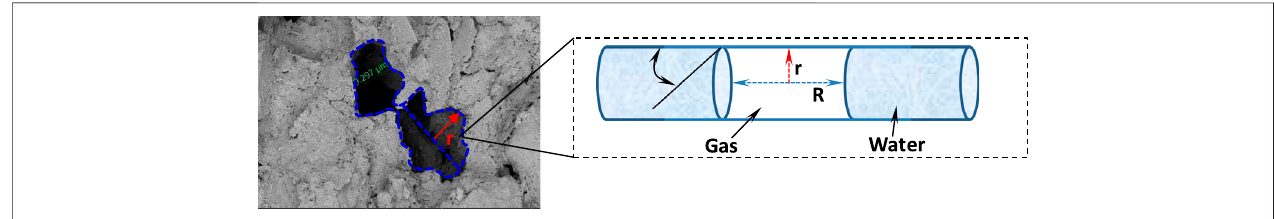
FIGURE 14 | Schematic diagram of pore pressure due to capillary force.